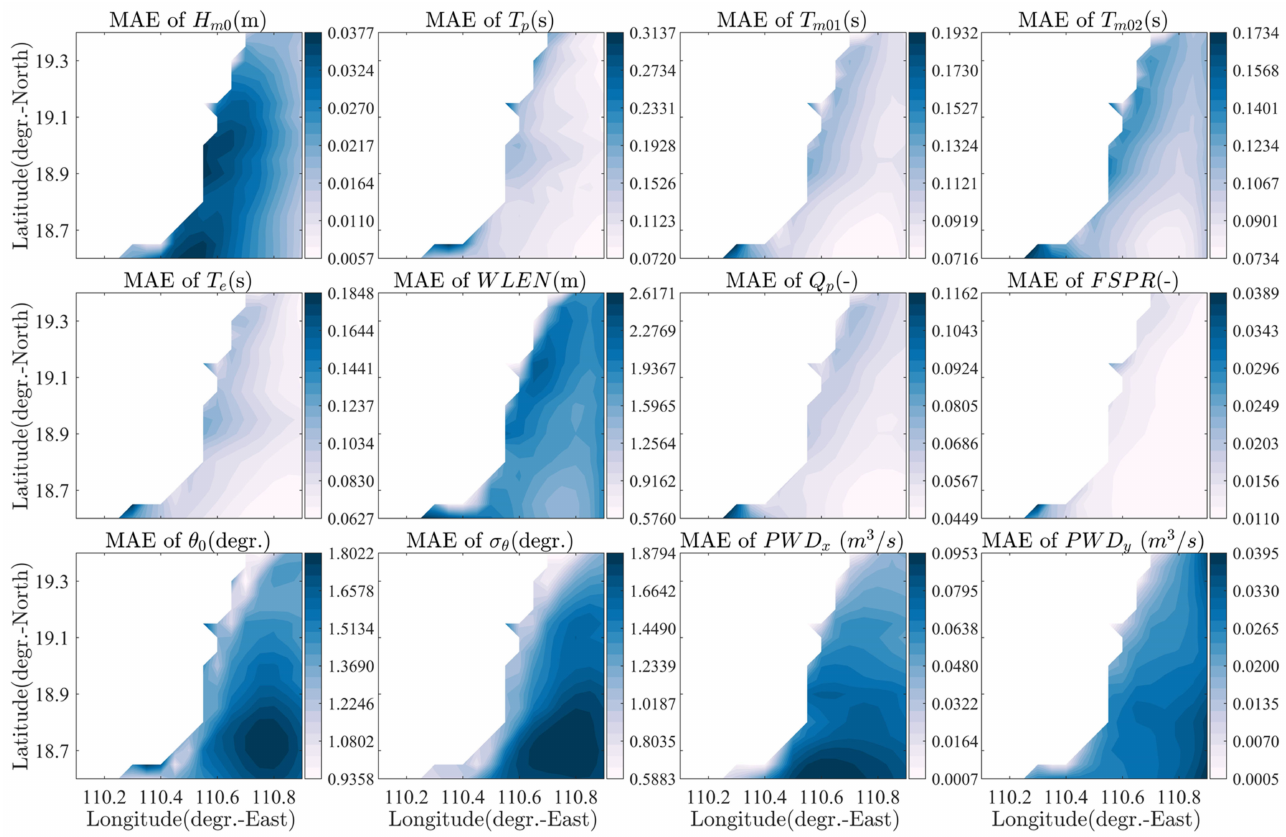
Figure 6. Spatial distributions of MAE of the KPs derived from the SWAN BLOCK outputs. In each panel, the values of MAE are indicated by the colors, the title identifies the corresponding KP, and the x and y axes denote the longitude ( ◦ E) and latitude ( ◦ N), respectively.